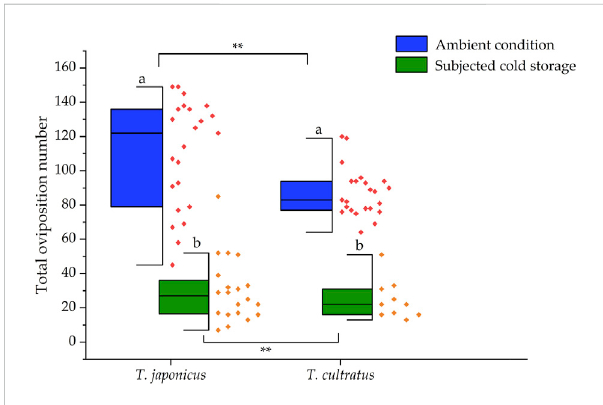
FIGURE 1 Number of parasitoids produced per parental female of T. japonicus and T. cultratus placed under ambient (25 ° C) versus subjected to cold storage. Asterisks represent signi fi cant differences between T. japonicus and T. cultratus within the same treatment (** p < 0.01).Differentlettersrepresentsigni fi cantdifferencesbetween ambient temperature (25 ° C) and subjected to cold storage conditions within each parasitoid species ( p <